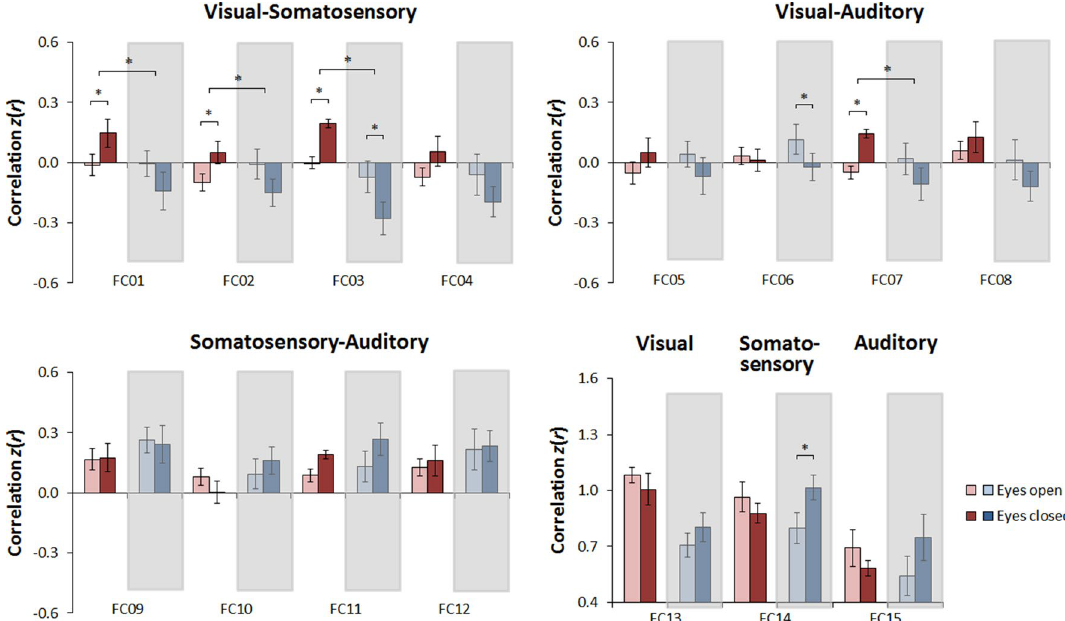
Figure 2. Effects of resting state condition in Study 2, separately by group (gray insets highlight the congenitally blind group). Shown is the average functional connectivity with the standard error of the mean in the eyes open condition (light red and light blue bars) and in the eyes closed condition (dark red and dark blue bars), plotted separately for normally sighted controls (red bars) and congenitally blind individuals (blue bars), for each instance of functional connectivity examined (for details, see Table 3). Note that this figure is equivalent to Fig. 3; here, the bars were organized to depict the effects of resting state condition separately by group.